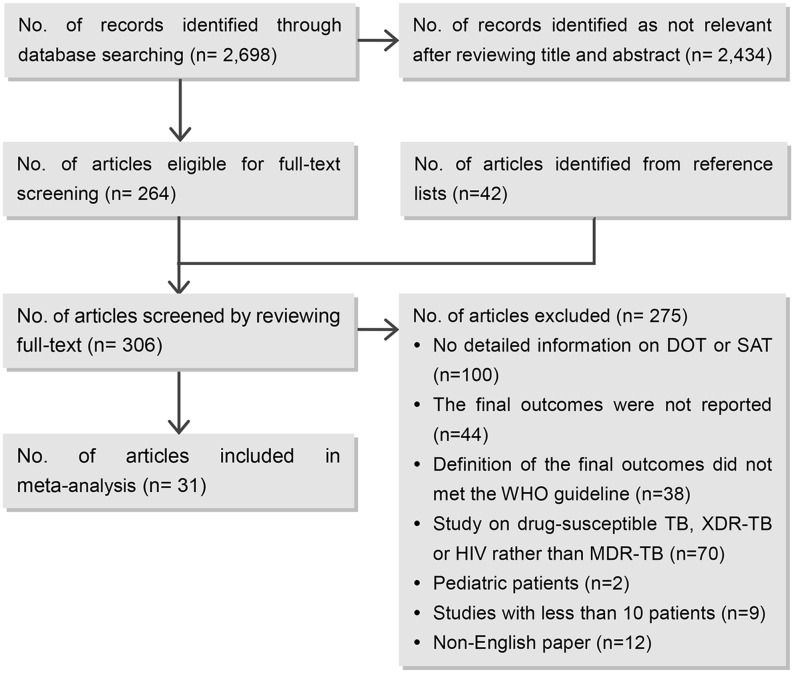
Summary of study selection process.No.: number; DOT: directly observed therapy; SAT: self-administration therapy; MDR-TB: multidrug-resistant tuberculosis; XDR-TB: extensively drug-resistant tuberculosis.